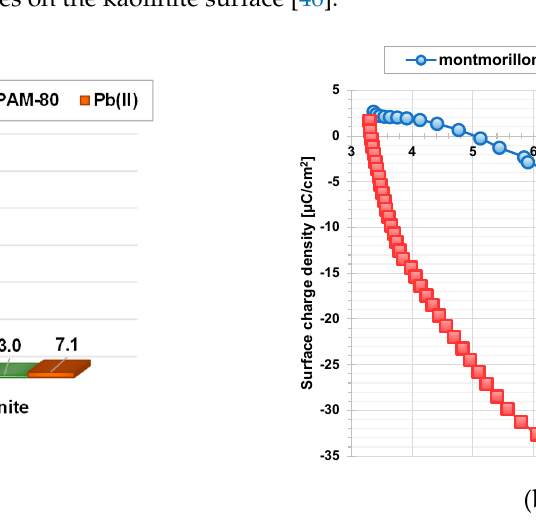
Figure 2. ( a ) Adsorbed amounts of cationic PAMs and heavy metal ions on the montmorillonite and kaolinite surface at pH 5; initial concentration of adsorbates is 100 mg/L; ( b ) surface charge density of minerals as a function of solution pH.